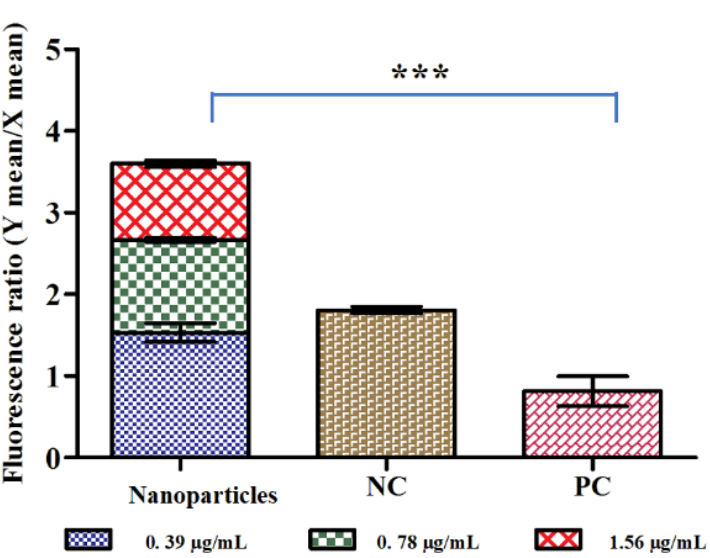
Figure 6. The fluorescence ratio (Y mean/X mean) as an indicator of depolarization is shown in the bar graph. Y mean represents JC-10 aggregates and X mean represents JC-10 monomers. A decrease in mitochondrial membrane potential was observed in treated C. auris cells compared to untreated control cells. NC: negative control; PC: positive control. *** p ≤ 0.05.